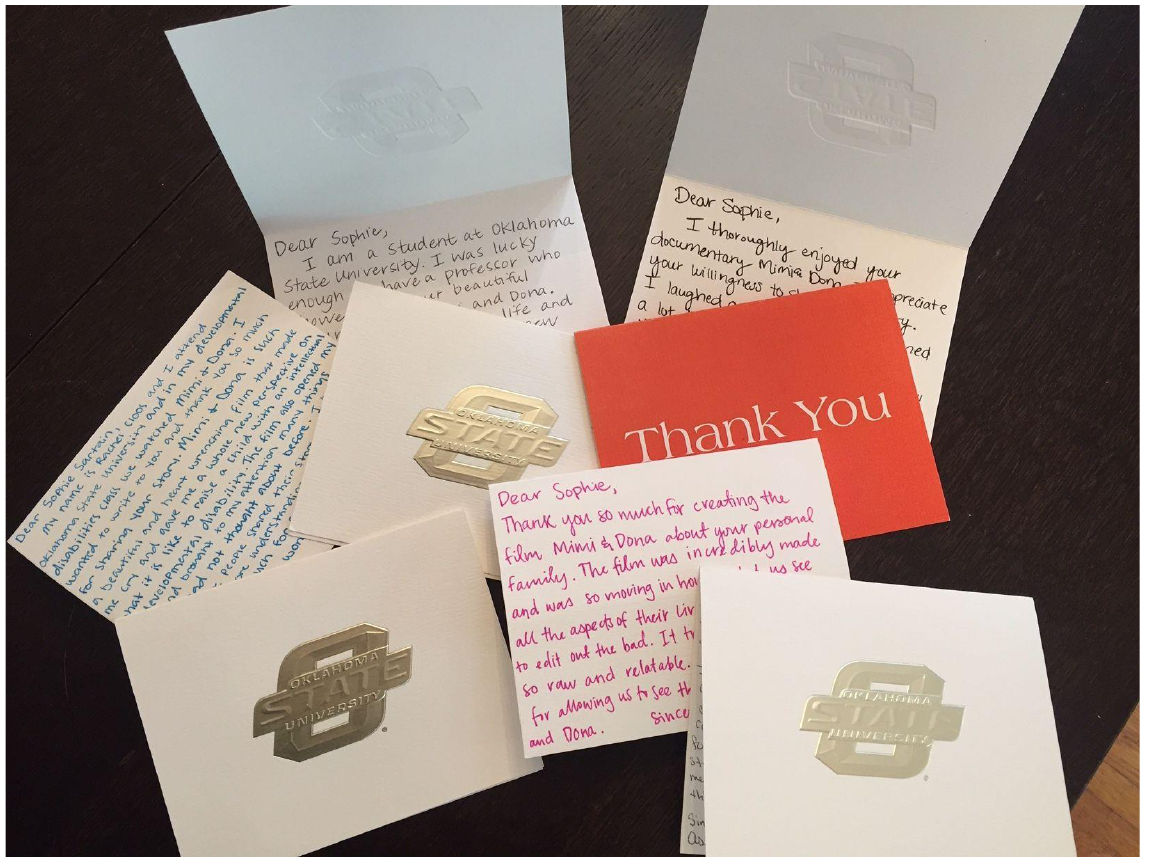
Figure 9: Notes from students at Oklahoma State University who watched the film in a class. Courtesy: Sophie